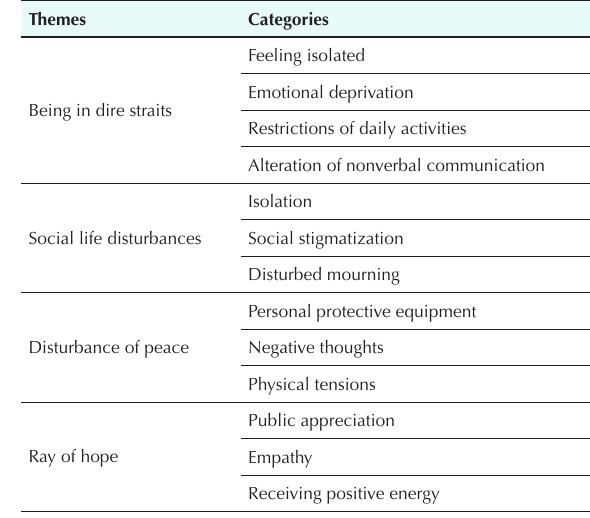
Table 1. Participants’ demographic characteristics Characteristics